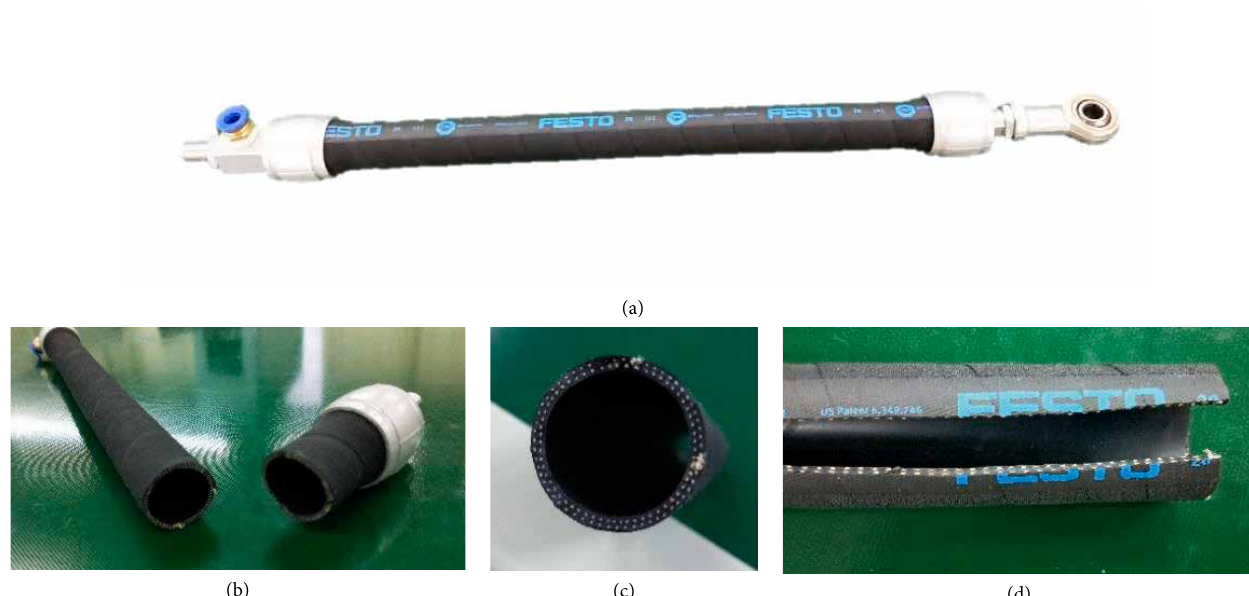
Figure 2: Structure of PAM. (a) The whole PAM. (b) Cut position. (c) Radial section. (d) Axial section.